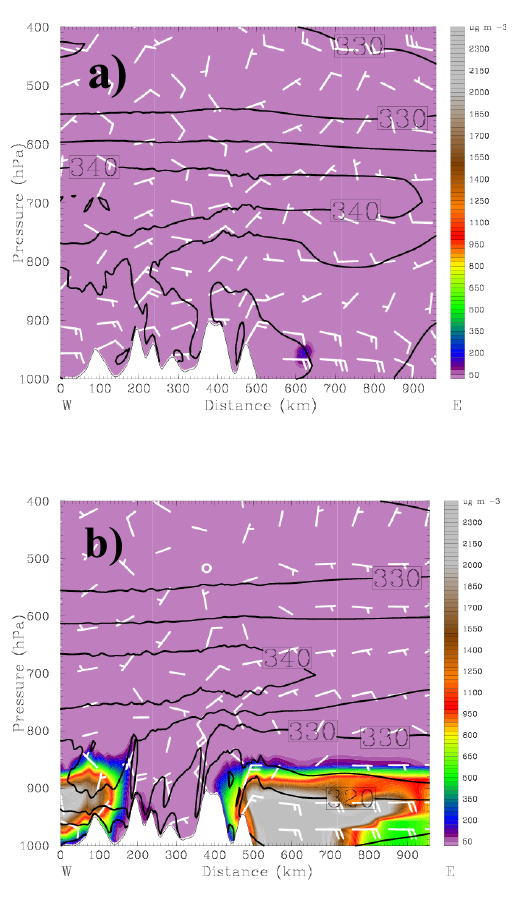
Fig. 12. The cross-section distribution of wind field, theta-e (con- tour) and PM 10 concentration (colored) along EW1 in Fig. 9 at (a) 14:00UTC, 20 March (b) 20:00UTC, 20 March. A full (half) wind barb indicates 5ms − 1 (2.5ms − 1